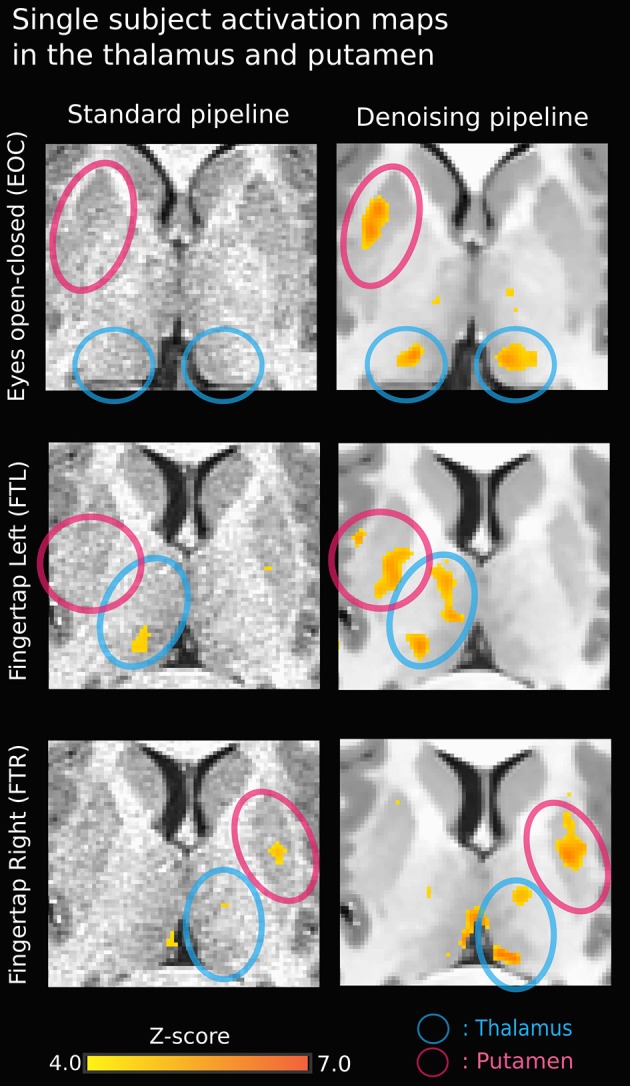
Single-subject activation map using NLM denoising (right) yields stronger thalamic activation in all three tasks compared to standard approach (left). The activation in the bottom right image (FTR - denoised) near the left thalamus may be a veinous artifact.